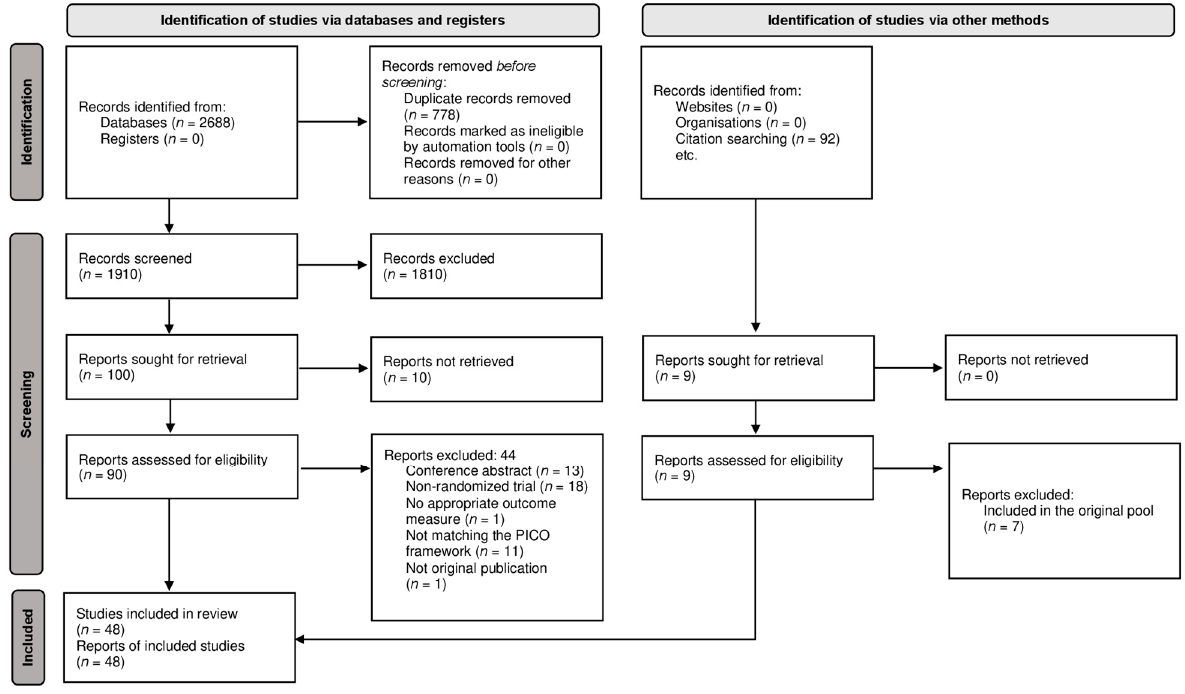
Figure 1. PRISMA Flow Diagram of the screening and selection process.